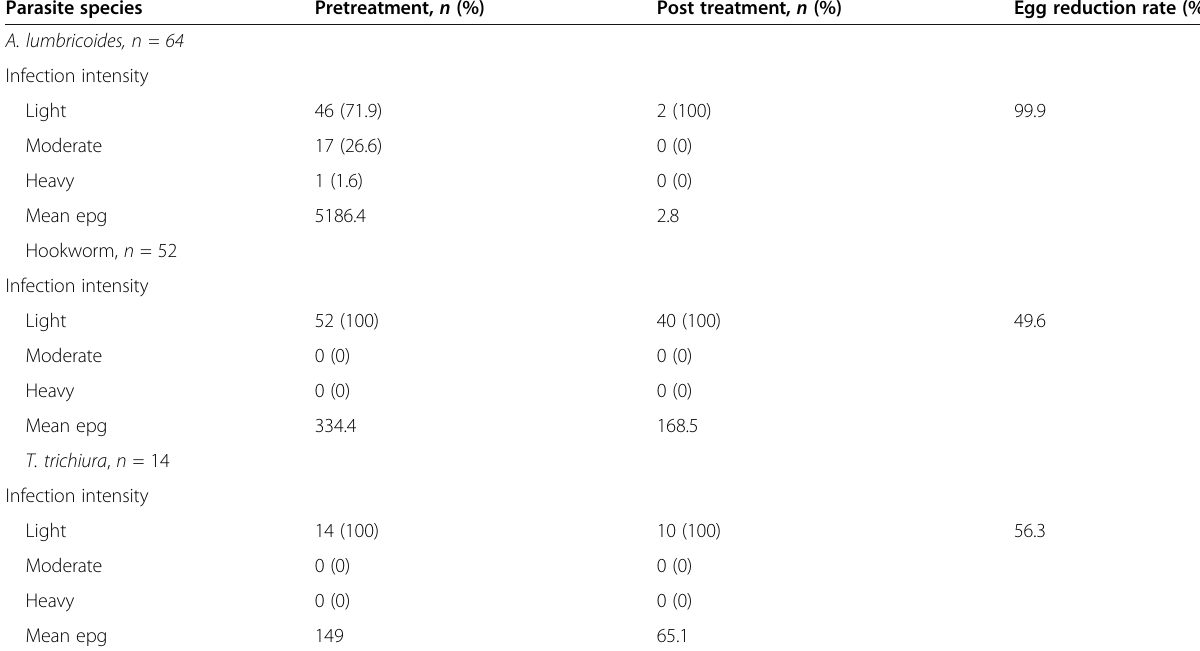
Table 2 STH infection intensity and egg reduction rates in pre- and post-treatment periods among schoolchildren in Northwest Ethiopia,